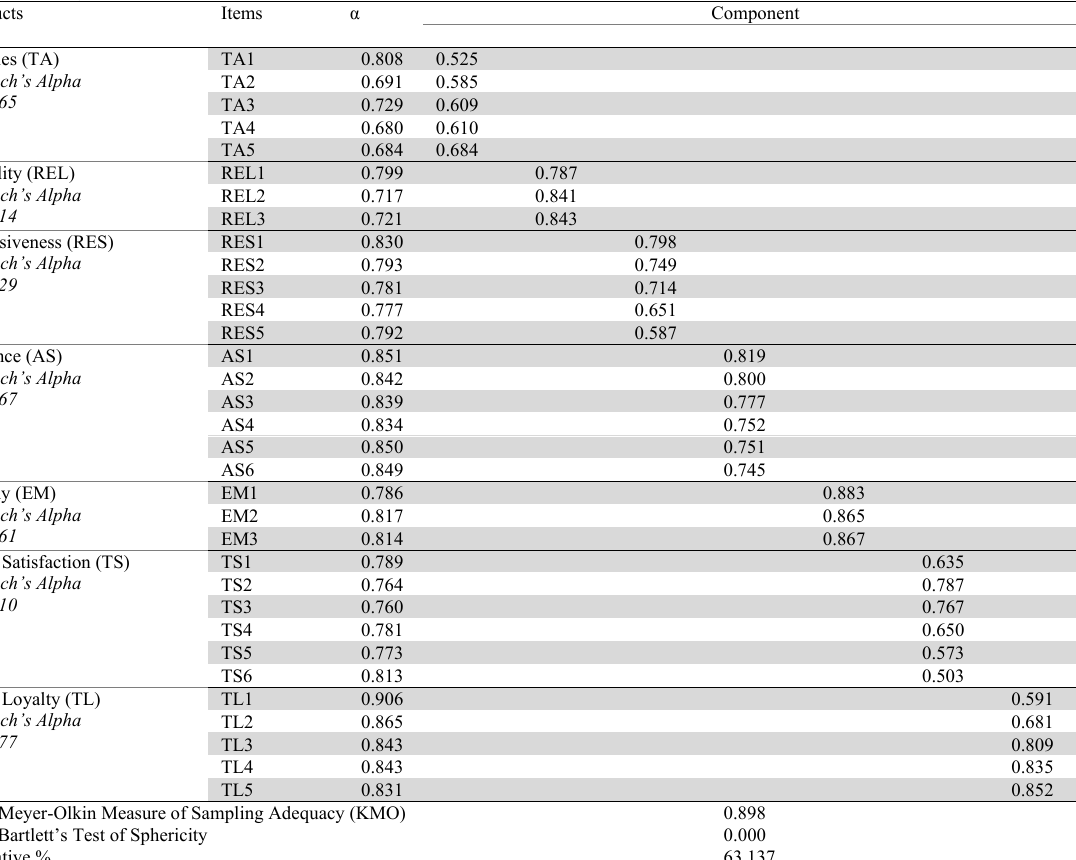
The reliability of